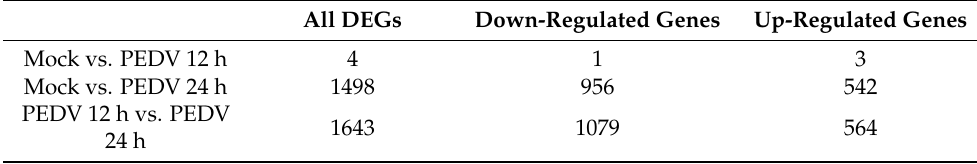
Table 2. Numbers of differentially expressed genes